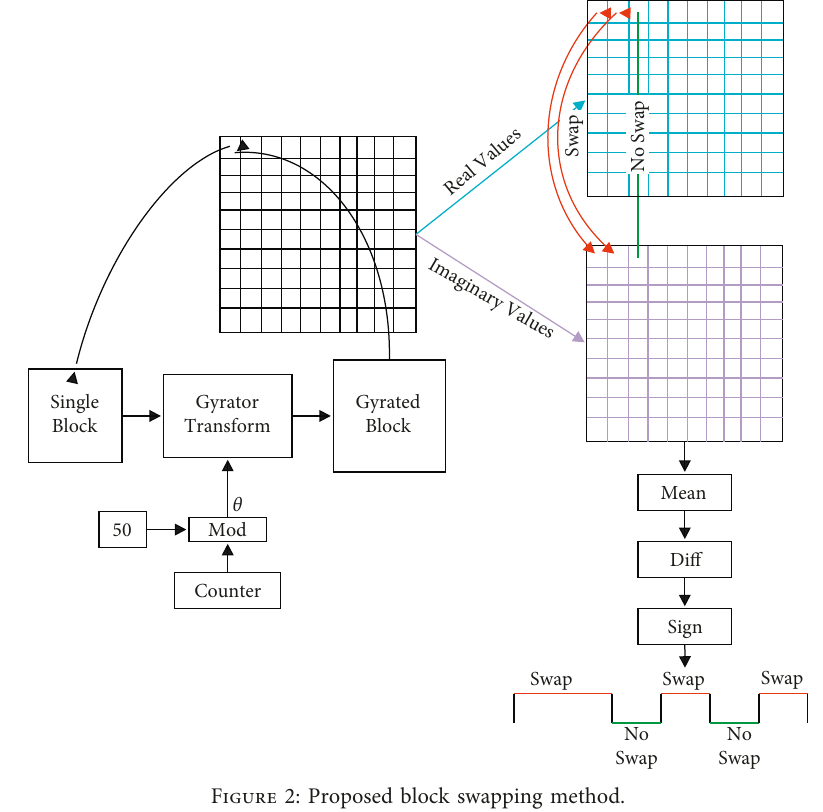
Figure 2: Proposed block swapping method.